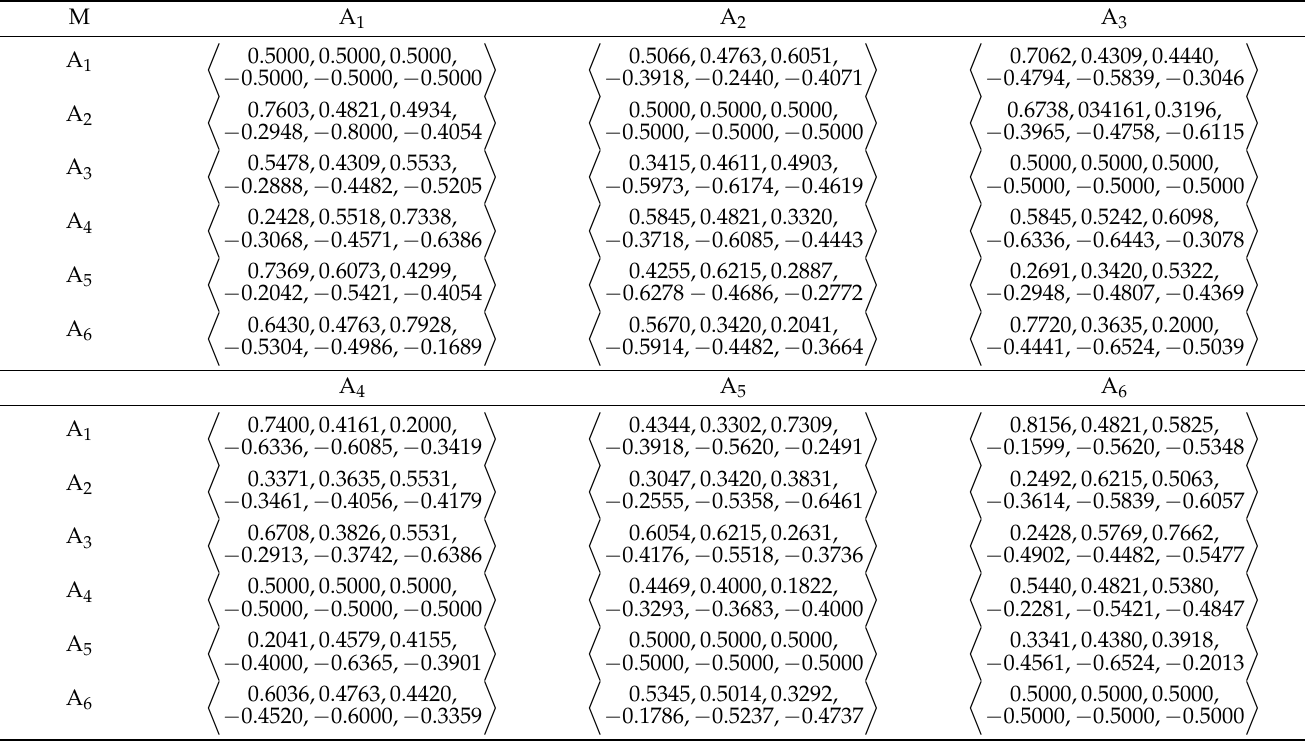
Table 15. The collective BSVNPR of all the above individual